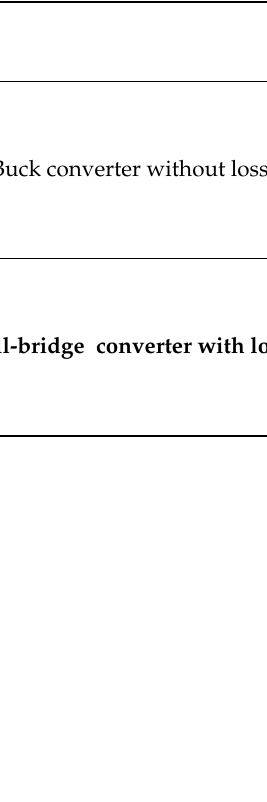
Table 6. FPGA resources use in RT for fixed-point design alternatives using TW + 2 NBL method. Design